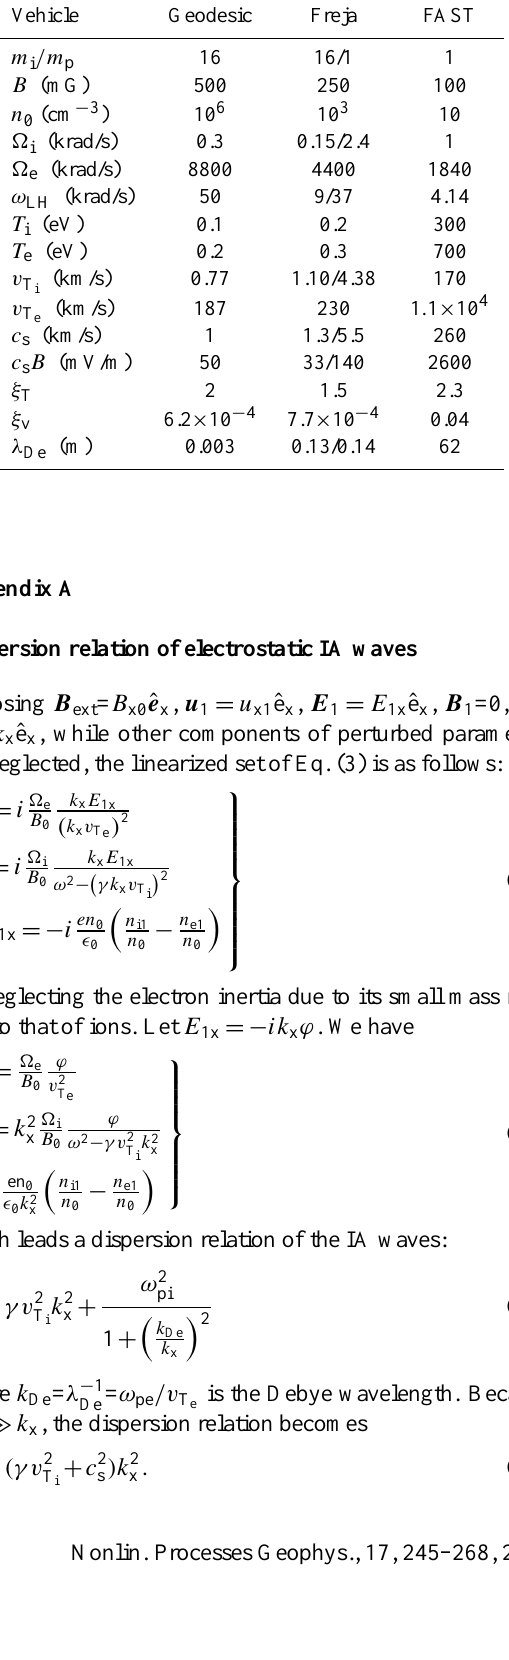
Table 1. Some typical plasma parameters in auroral plasmas mea- sured by the Geodesic rocket (Burchill et al., 2004), the Freja satel- lite (Eriksson et al., 1994), and the FAST satellite (Ergun, 1999).